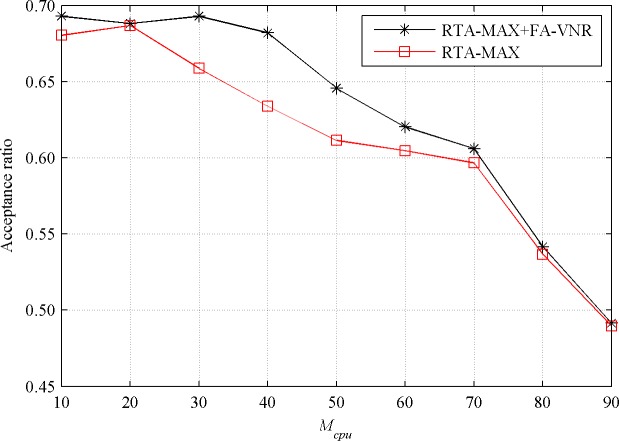
Acceptance ratio with increasing Mcpu.